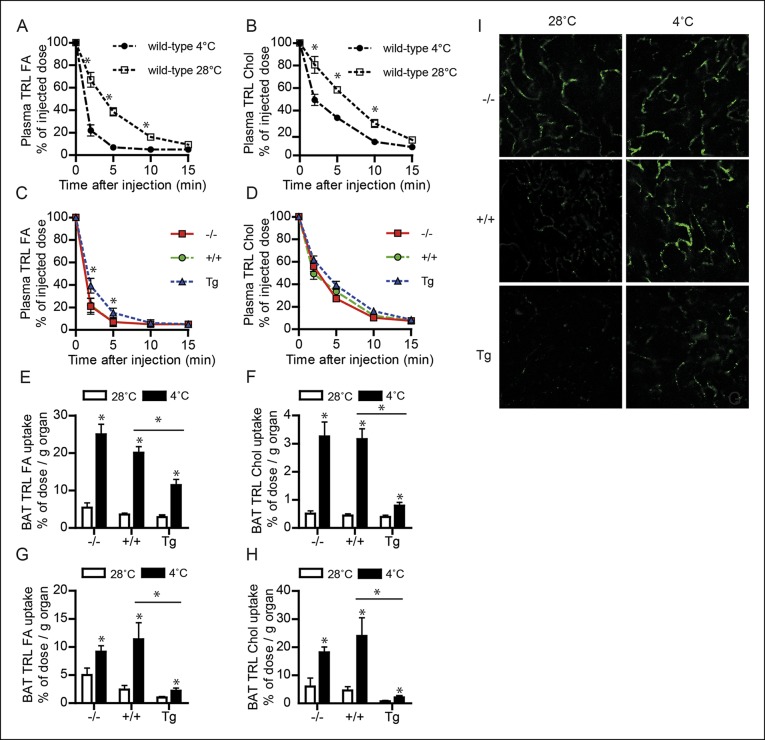
Down-regulation of ANGPTL4 in BAT upon sustained cold exposure promotes an increase in TRL-derived fatty acid uptake by BAT.(A,B) Plasma 3H (A) and 14C (B) activity in wild-type mice exposed to 4°C or 28°C for 10 days intravenously injected with VLDL-like particles labelled with glycerol tri[3H]oleate (TRL FA) and [14C]cholesteryl-oleate (TRL Chol). (C,D) Plasma 3H (C) and 14C (D) activity in Angptl4-/-, wild-type and Angptl4-Tg mice intravenously injected with VLDL-like emulsion particles labelled with glycerol tri[3H]oleate (TRL FA) and [14C]cholesteryl-oleate (TRL Chol), following exposure to 4°C for 10 days. (E,F) 3H activity (E) and 14C activity (F) in interscapular BAT of Angptl4-/-, wild-type and Angptl4-Tg mice exposed to 4°C or 28°C for 10 days and intravenously injected with VLDL-like particles labelled with glycerol tri[3H]oleate (TRL FA) and [14C]cholesteryl-oleate (TRL Chol). (G,H) 14C and 3H activity in interscapular BAT of Angptl4-/-, wild-type and Angptl4-Tg mice exposed to 4°C or 28°C for 10 days and intravenously injected with chylomicron-like particles labelled with glycerol tri[14C]oleate (TRL FA) (G) and [3H]cholesteryl-oleyloleate (TRL Chol). (I) Fluorescent image of uptake of intravenously injected QD-TRLs into BAT of Angptl4-/-, wild-type and Angptl4-Tg mice exposed to 4°C or 28°C for 9 days. Image was taken 12 min post-injection. n = 2 mice per group.* Statistically significant compared to mice of equal genotype at 28°C or between groups as indicated by bars, according to two-way ANOVA followed by a post-hoc Tukey HSD test (p<0.05). Error bars represent ± SEM. n = 7 mice per group, unless otherwise indicated.